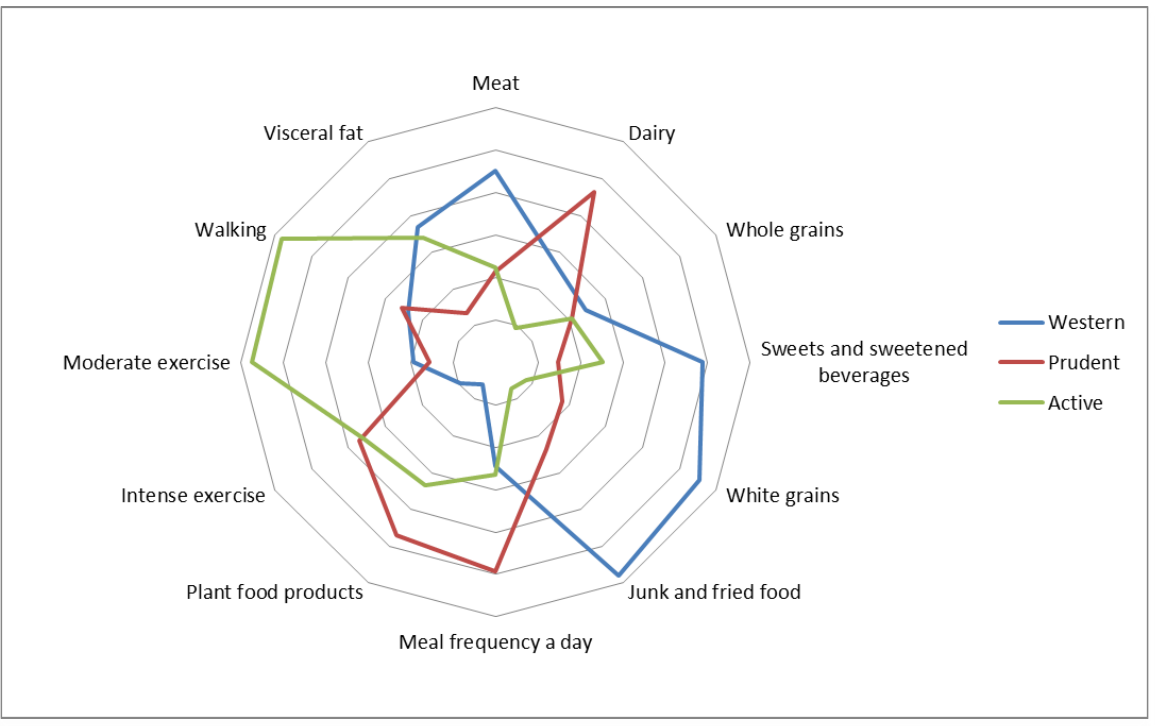
Figure 2. Factor loadings diagram characterising dietary-lifestyle patterns distinguished among women with PCOS.